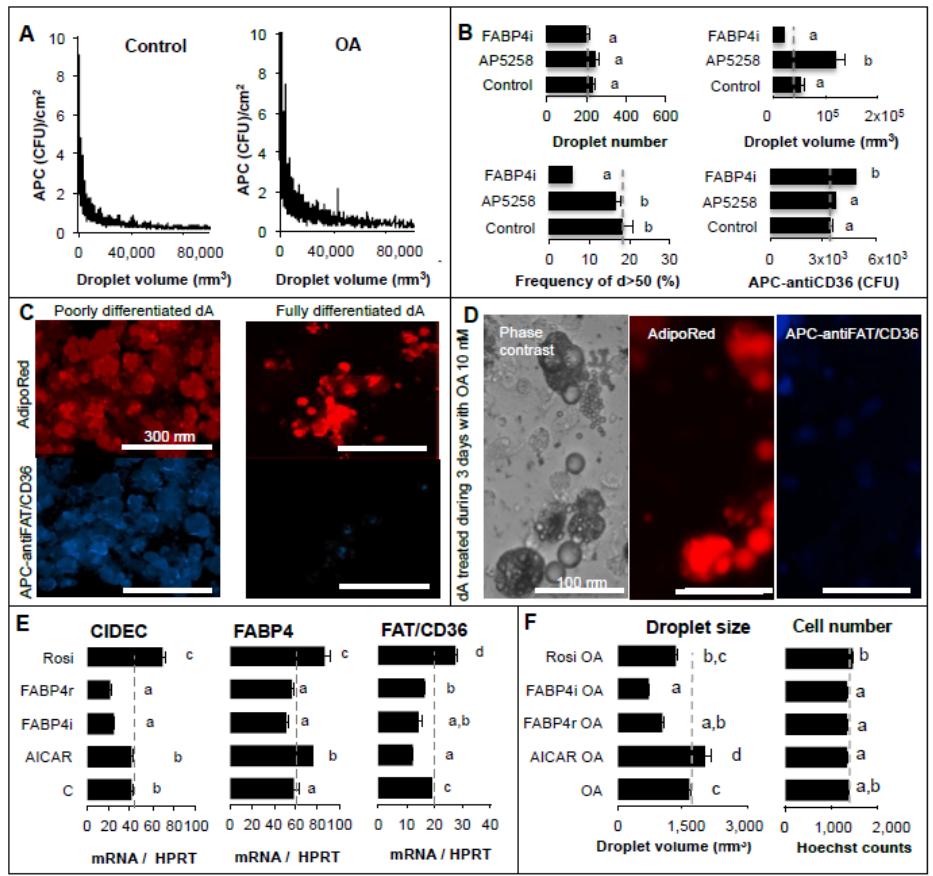
Figure 4. FAT/CD36 expression and activity in adipocytes. ( A – D ) The active form of FAT/CD36 was detected using an APC-coupled antibody directed against the extracellular part of the protein (blue color). Lipid droplets were labeled with AdipoRed (red color) and analyses were performed on 3T3-L1 adipocytes 3 days after treatment with oleic acid 10 µ M: ( A ) Distribution of extracellular FAT/CD36 co-localized with lipid droplets (env. 5000 counts) is inversely regulated with droplet size. ( B ) Inhibitors of FAT/CD36 (AP5258 1 µ M) and FABP4 (FABP4i 20 µ M) did not affect droplet number (upper left panel), inhibition of FAT/CD36 promoted the increase of droplet size (upper right panel) although inhibition of FABP4 reduced the frequency of droplets with size up to 50 µ m (lower left panel) and increased extracellular FAT/CD36 (lower right panel). ( C ) AdipoRed and APC-FAT/CD36 antibody detection on poorly vs. highly differentiated adipocytes and ( D ) in OA-treated adipocytes. ( E ) Gene transcription analysis of 3T3-MBX adipocytes treated over 3 days with oleic acid 5 µ M in order to induce adipogenic genes, then 48 h, with either recombinant FABP4r (20 ng/mL), an inhibitor of FABP4 (FABP4i 20 µ M), AMPK activator (AICAR 1 mM) or PPARG activator (rosiglitazone (20 µ M). The effects on gene transcription for CIDEC , FABP4 , and FAT /CD36 were normalized to the standard HPRT gene. Results are presented as mean +/ − SEM: n = 8 biological replicates with 3 images at objective × 4 per sample in ( B , F ), mean +/ − SD in (E) (n = 4 replicates). ( F ) Then their capacity to increase droplet size (left panel) without significant effect on cell number (right panel) was assessed 3 days after treatment with oleic acid (OA 10 µ M). ( E ) Results are presented as mean +/ − SEM (n = 8 biological replicates). Different letters represent significant differences (Anova, p <